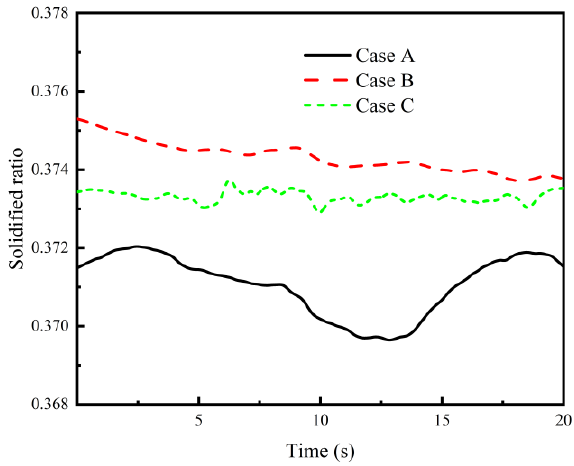
Figure 17. Solidified ratio at the mold outlet.